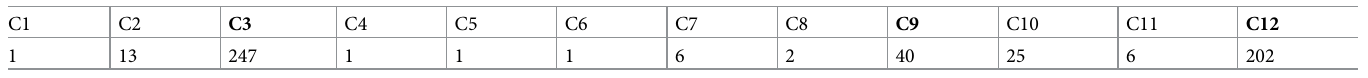
C 11; see Table 4). As for group 1, we observed a steady decrease in the between inertia after K = 2 (see Figs 6 and 7) and again, after K = 12, we observed the same scenario as with group 1: mostly, cluster C 6 gets split into subsequent pairs of small and big clusters. K = 12 seems there- fore a sensible choice in this case. The variables that characterize group 2 are “Expected target needs”, “Expected activities”, “Expected target students”, and “Student status” with p- value < 0.001 and “Age bin” with p-value < 0.01, as obtained with a χ 2 test. The set of variables that characterize each cluster are listed in S3 and S4 Tables of the S1 Appendix. Table 4. Characterization of the clusters in group